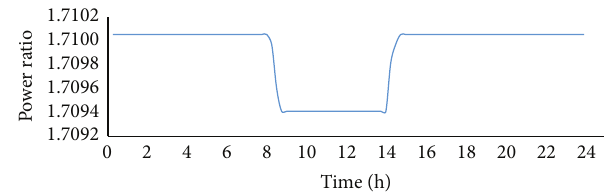
Figure 3: Trend of the power ratio at the initialization of the cruise phase.